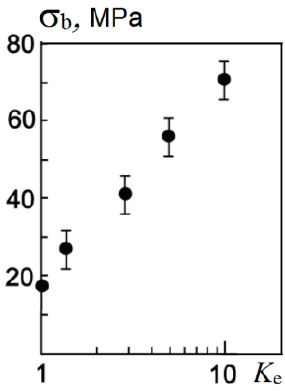
Figure 7. Influence of the extrusion ratio on the ultimate bending strength of Bi 0.91 Sb 0.09 crystals. The value of K e = 1 corresponds to single-crystal samples. Test temperature was 80 K. Table 3. Bending strength of extruded Bi – Sb polycrystals depending on the test temperature.